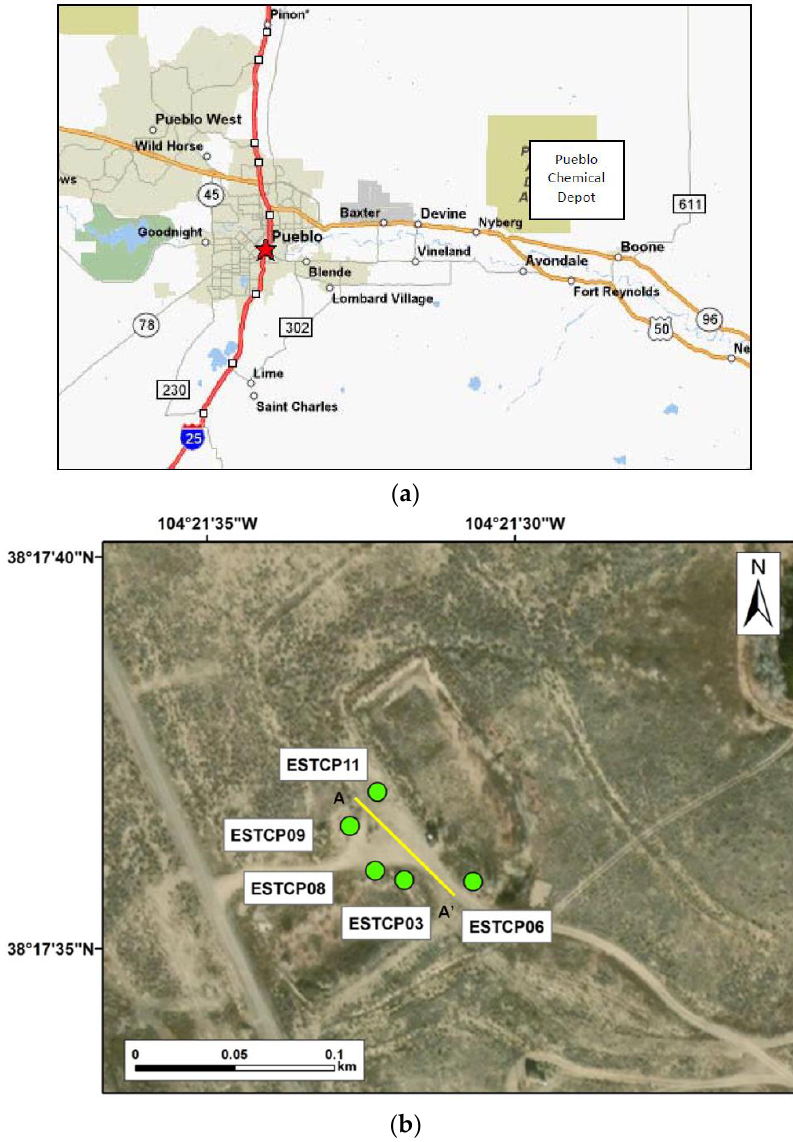
Figure 1. ( a ) Location of Pueblo Chemical Depot (PCD) near Pueblo, Colorado (CO) [17]. ( b ) Monitoring wells established in the Pueblo Chemical Depot area. Water 2020 , 12 , x FOR PEER REVIEW